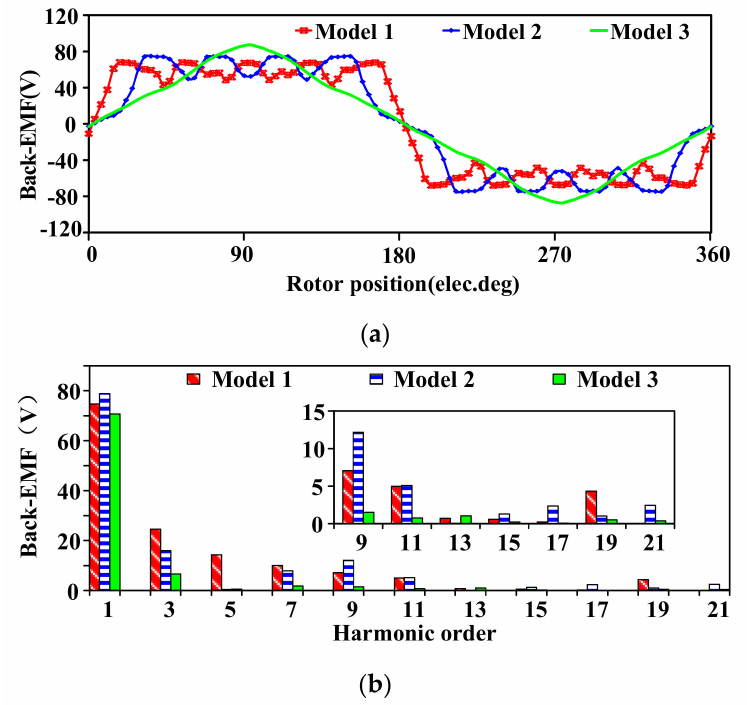
Figure 10. Back − EMFs of the three models. ( a ) Waveforms. ( b )